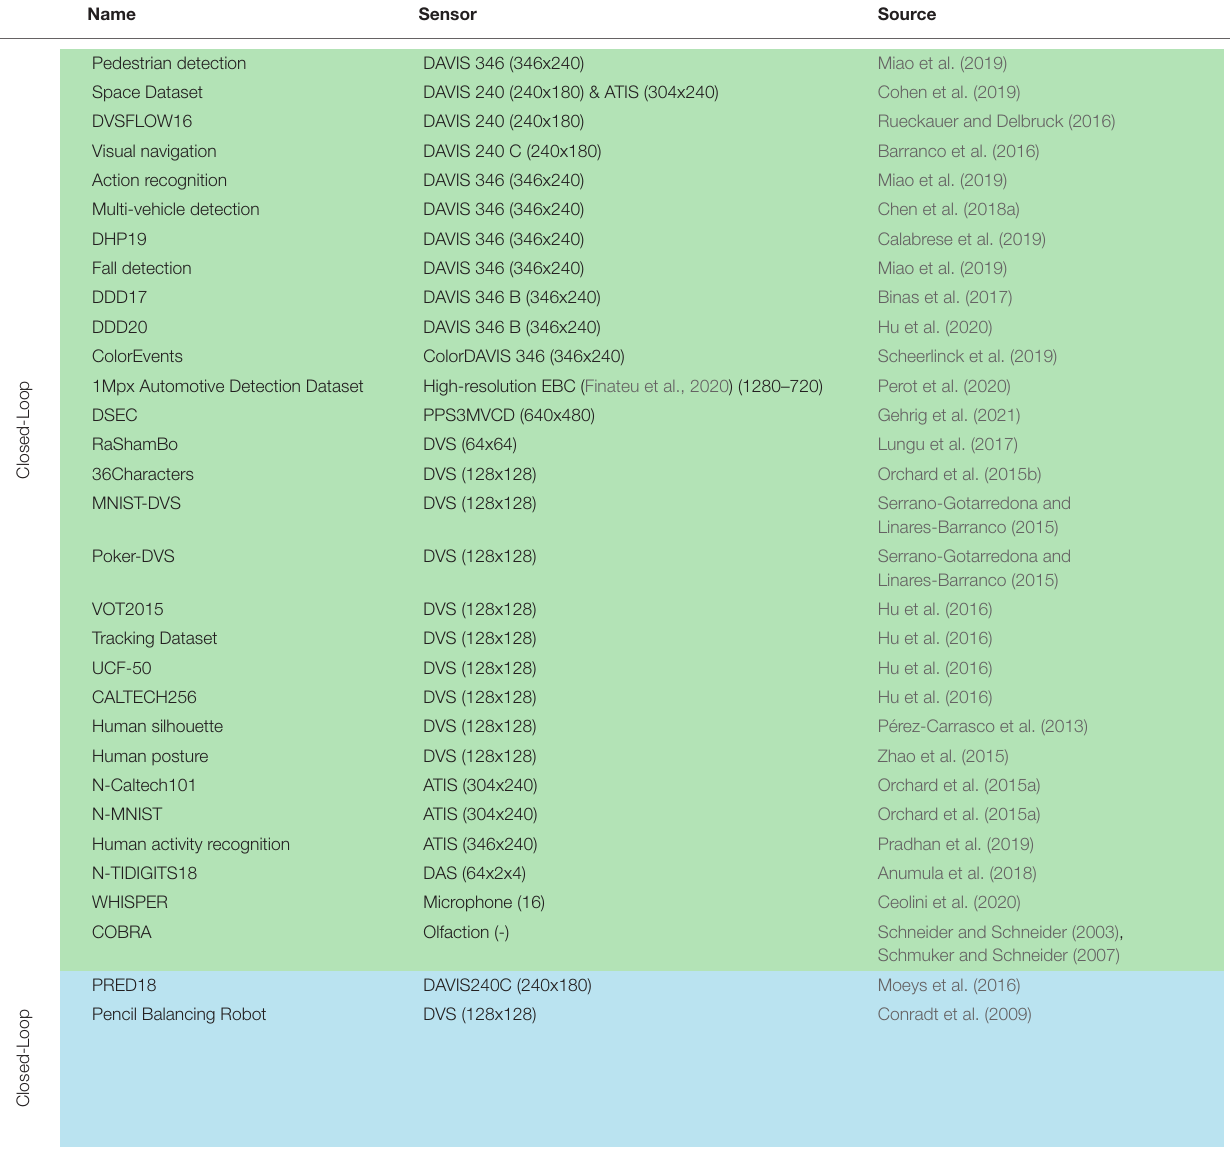
TABLE 2 | Neuromorphic Benchmark Datasets for various sensor